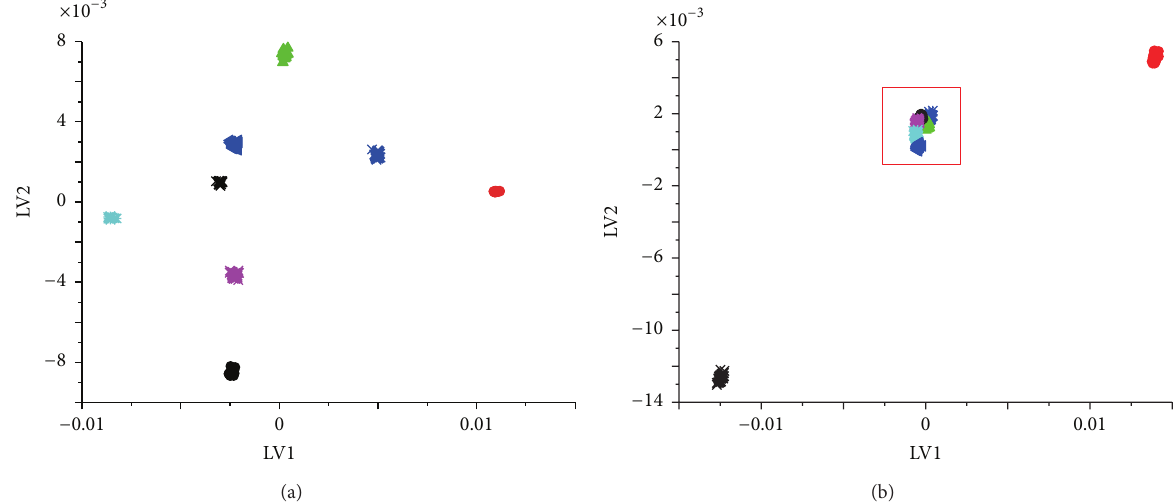
Figure 5: Score plots of the raw NIR spectra by LDA of 8 different kinds of Hibiscus mutabilis L. samples in training sets and in prediction